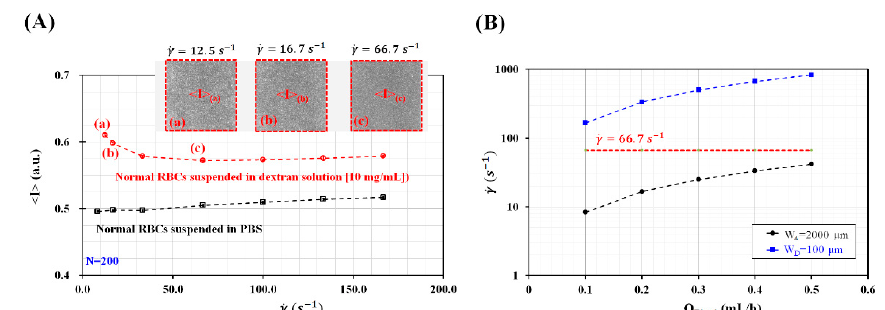
Figure 2. Determination of the widths of the wide and narrow channels. ( A ) Variations of image . γ = . γ = . γ = . γ intensity (<I>) with respect to shear rate ( γ(cid:4662) ). Inset showed microscopic images captured with respect shear rate ((a) 12.5 s − 1 , (b) 16.7 s − 1 , and (c) 66.7 s − 1 ). ( B ) Variations of shear rate ( ) to shear rate ((a) γ(cid:4662) = 12.5 s (cid:2879)(cid:2869) , (b) γ(cid:4662) = 16.7 s (cid:2879)(cid:2869) , and (c) γ(cid:4662) = 66.7 s (cid:2879)(cid:2869) ). ( B ) Variations of of wide channel (W A = 2000 µ m) and narrow channel (W D = 100 µ m) with respect to blood flow rate shear rate ( γ(cid:4662) ) of wide channel (W A = 2000 µm) and narrow channel (W D = 100 µm) with respect to (Q Blood ) (Q Blood = 0.1, 0.2, 0.3, 0.4, and 0.5 blood flow rate (Q Blood ) (Q Blood = 0.1, 0.2, 0.3, 0.4, and 0.5 mL/h).